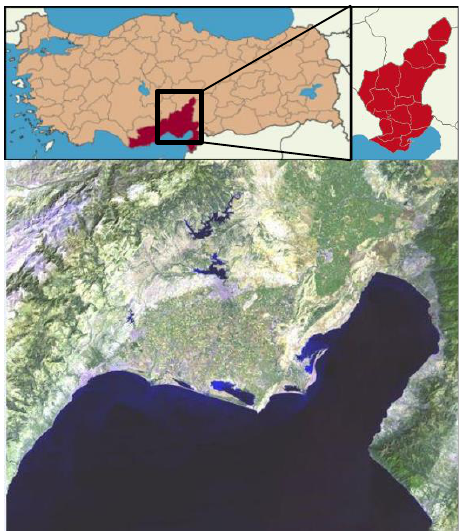
Figure1. The map and satellite image of the study area.